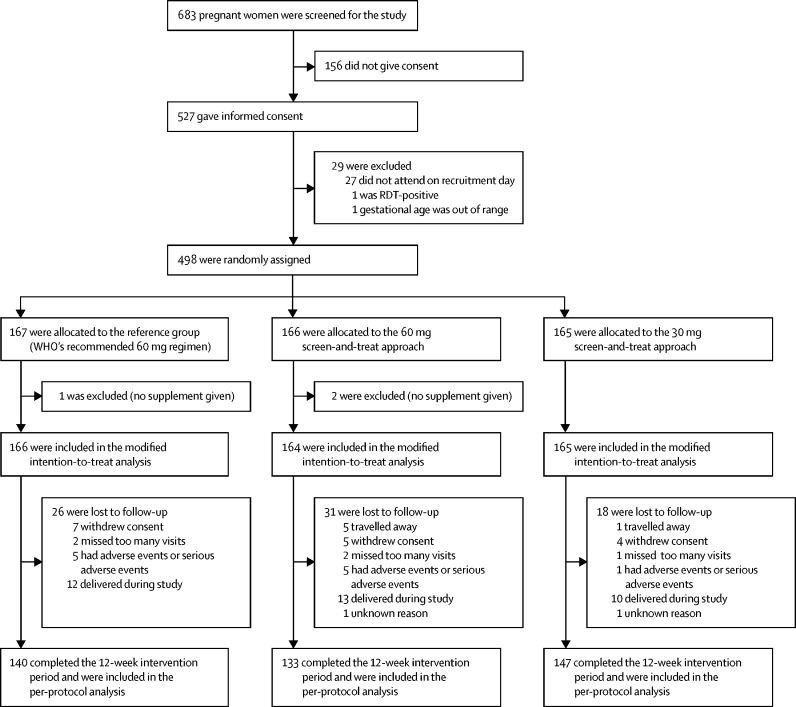
Trial profileRDT=rapid diagnostic test.